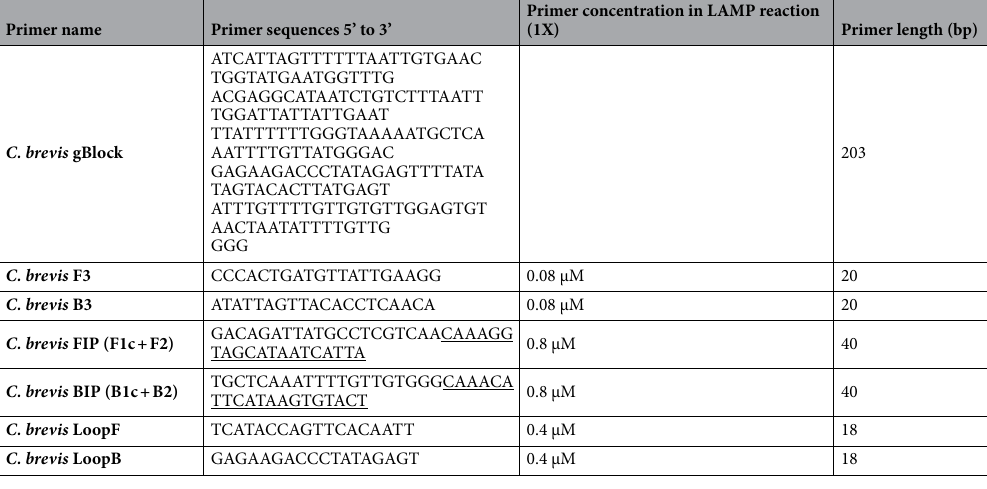
Table 2. LAMP primers sequence and concentration developed in this study. F3 forward outer primer, B3 reverse outer primer, FIP forward inner primer (comprising F1c and F2 sequences), BIP reverse inner primer (comprising B1c and B2 sequences), LB loop backward, LF loop forward. Sequences F2 and B2 are